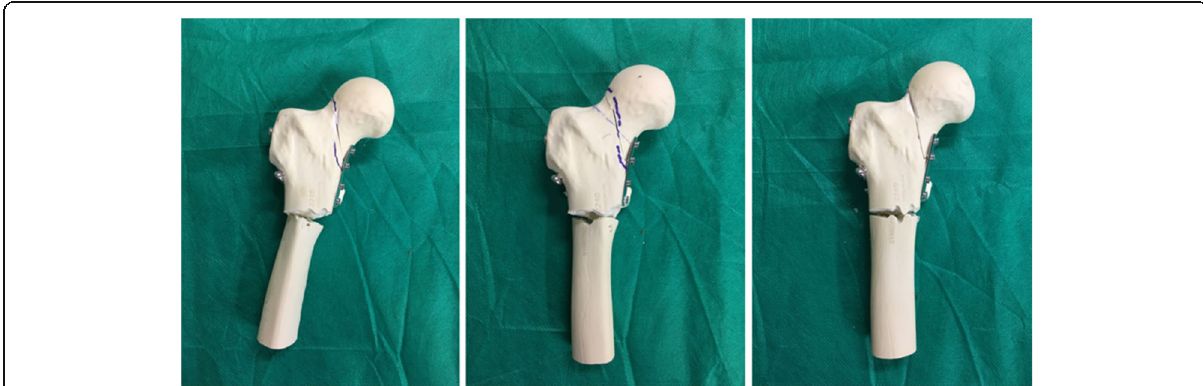
Fig. 4 Group 2, anterior view of three of the five test specimens used, with two parallel cannulated screws in the lower portion of the femoral neck + Pauwels screw + medial plate, showing the means of failure in this fixation